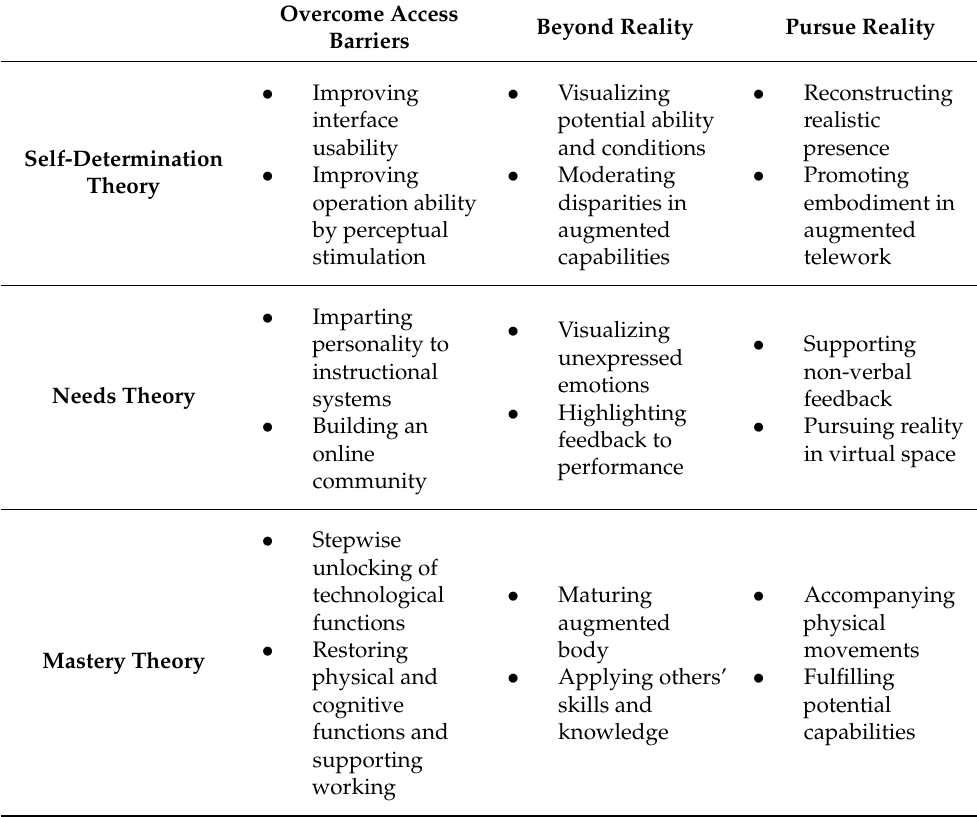
Table 2. Crosspoint framework for R&D Agenda of